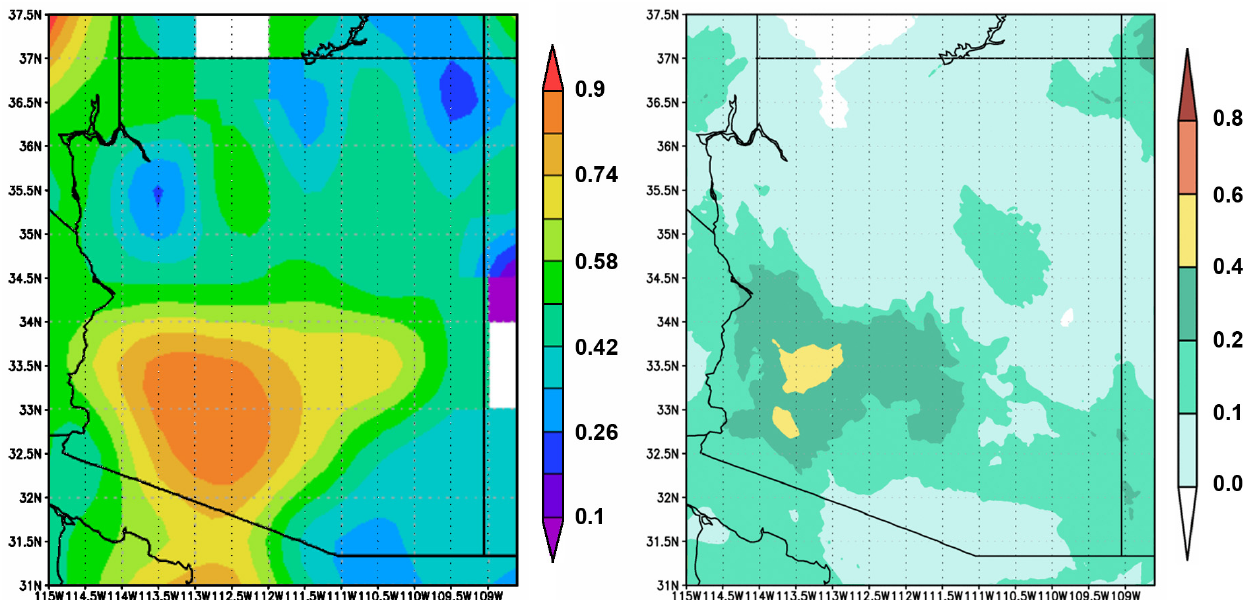
Fig. 12. Aqua MODIS aerosol optical depth (AOD) based on deep blue (DB) algorithm (left) and NMME–DREAM AOD (right) for the nighttime overpass